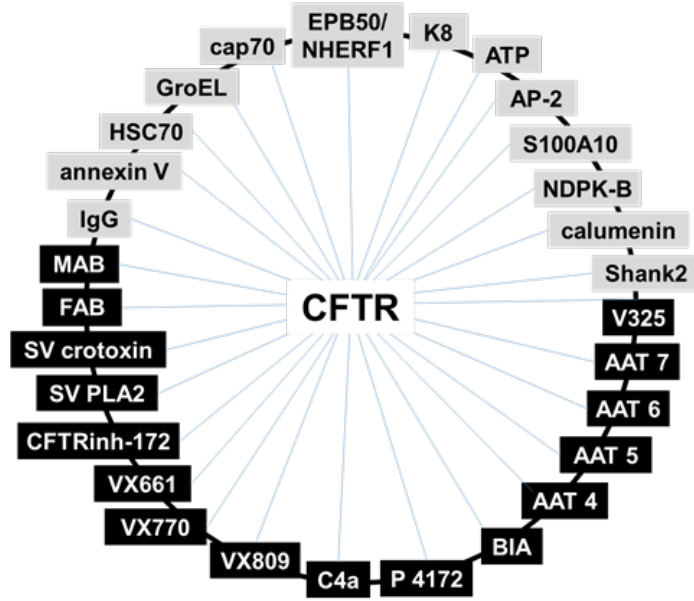
Figure 5. Schematic representation of CFTR intracellular interactome based on SPR studies. Natural intracellular CFTR-binders are indicated in grey, putative CFTR-rescuing drugs in black. P: pyrazole; SV: snake venom. See text for further details.